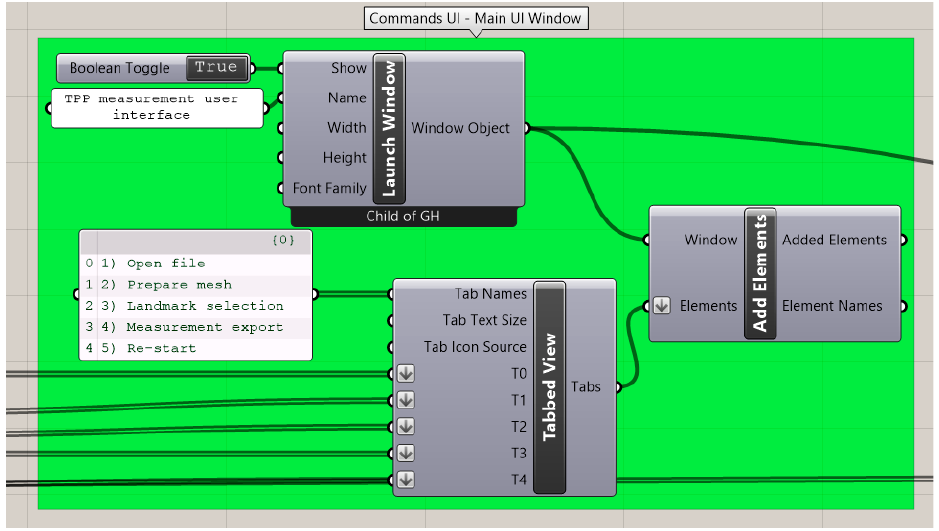
Figure 3. Main user interface (UI) commands from Human UI plugin for the generation of the main UI window and UI tool organization. Green background stands for UI commands.